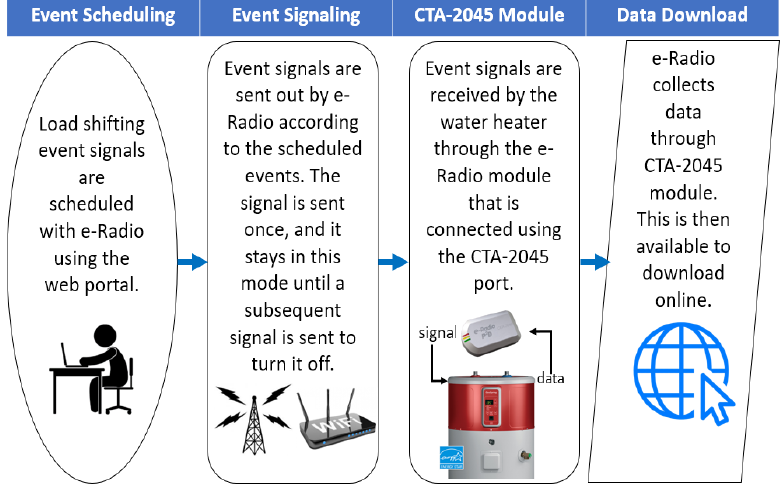
Figure 1. Wireless communication enabled through CTA-2045 module.